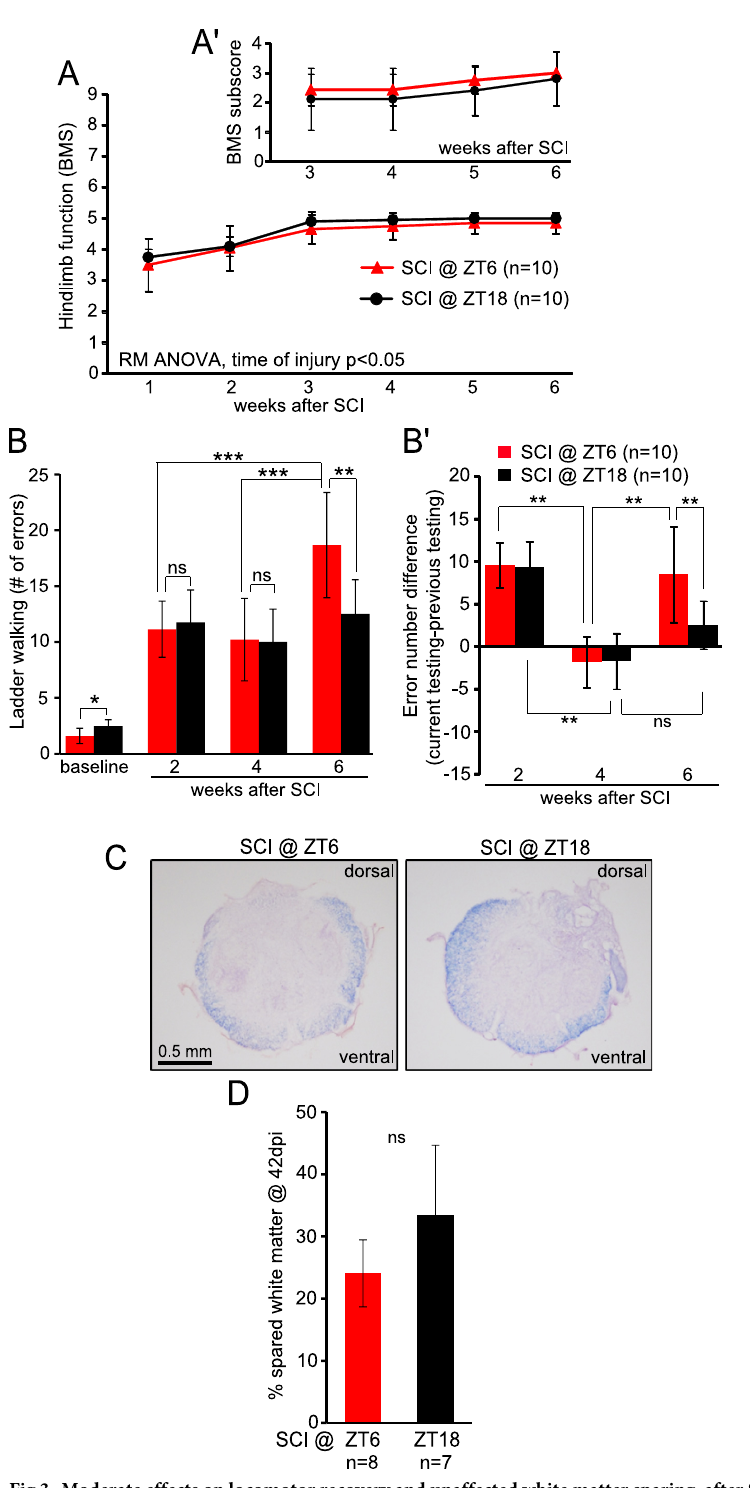
Fig 3. Moderate effects on locomotor recovery and unaffected white matter sparing, after SCI at ZT6 or ZT18. In study 2, SCI as well as functional and histological analyses were performed as described for study 1 (Fig 2). A , Despite the significant main effect in RMANOVA for time of injury, no significant group differences in BMS were observed with post hoc testing at any time point; BMS subscore (A’) was also unaffected. B , horizontal ladder walking test revealed higher number of errors in ZT6 vs. ZT18 mice at week 6 which and a minor opposite difference at the